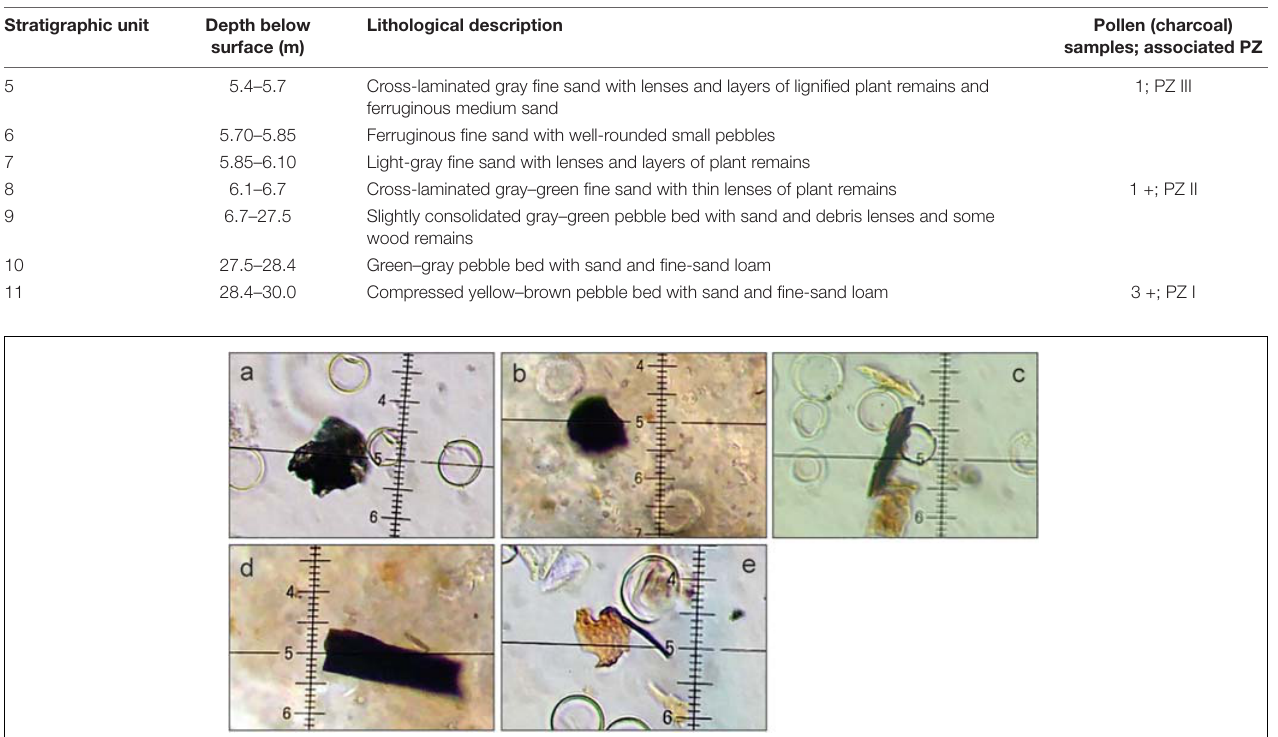
FIGURE 2 | Microscopic charcoal morphotypes common in the pollen samples of sections 119, 121 and 124: (a) translucent, irregular type M; (b) opaque irregular type P; (c) angular, translucent type B; (d) angular, opaque type C and (e) elongated type F. The globose and transparent cysts in all photos were possibly produced by the so-called snow-algae species from genera of Chlamydomonas , Chloromonas , Haematococcus ( Sphaerella ). Photos by Tabea Tessendorf (AWI), March 2020.